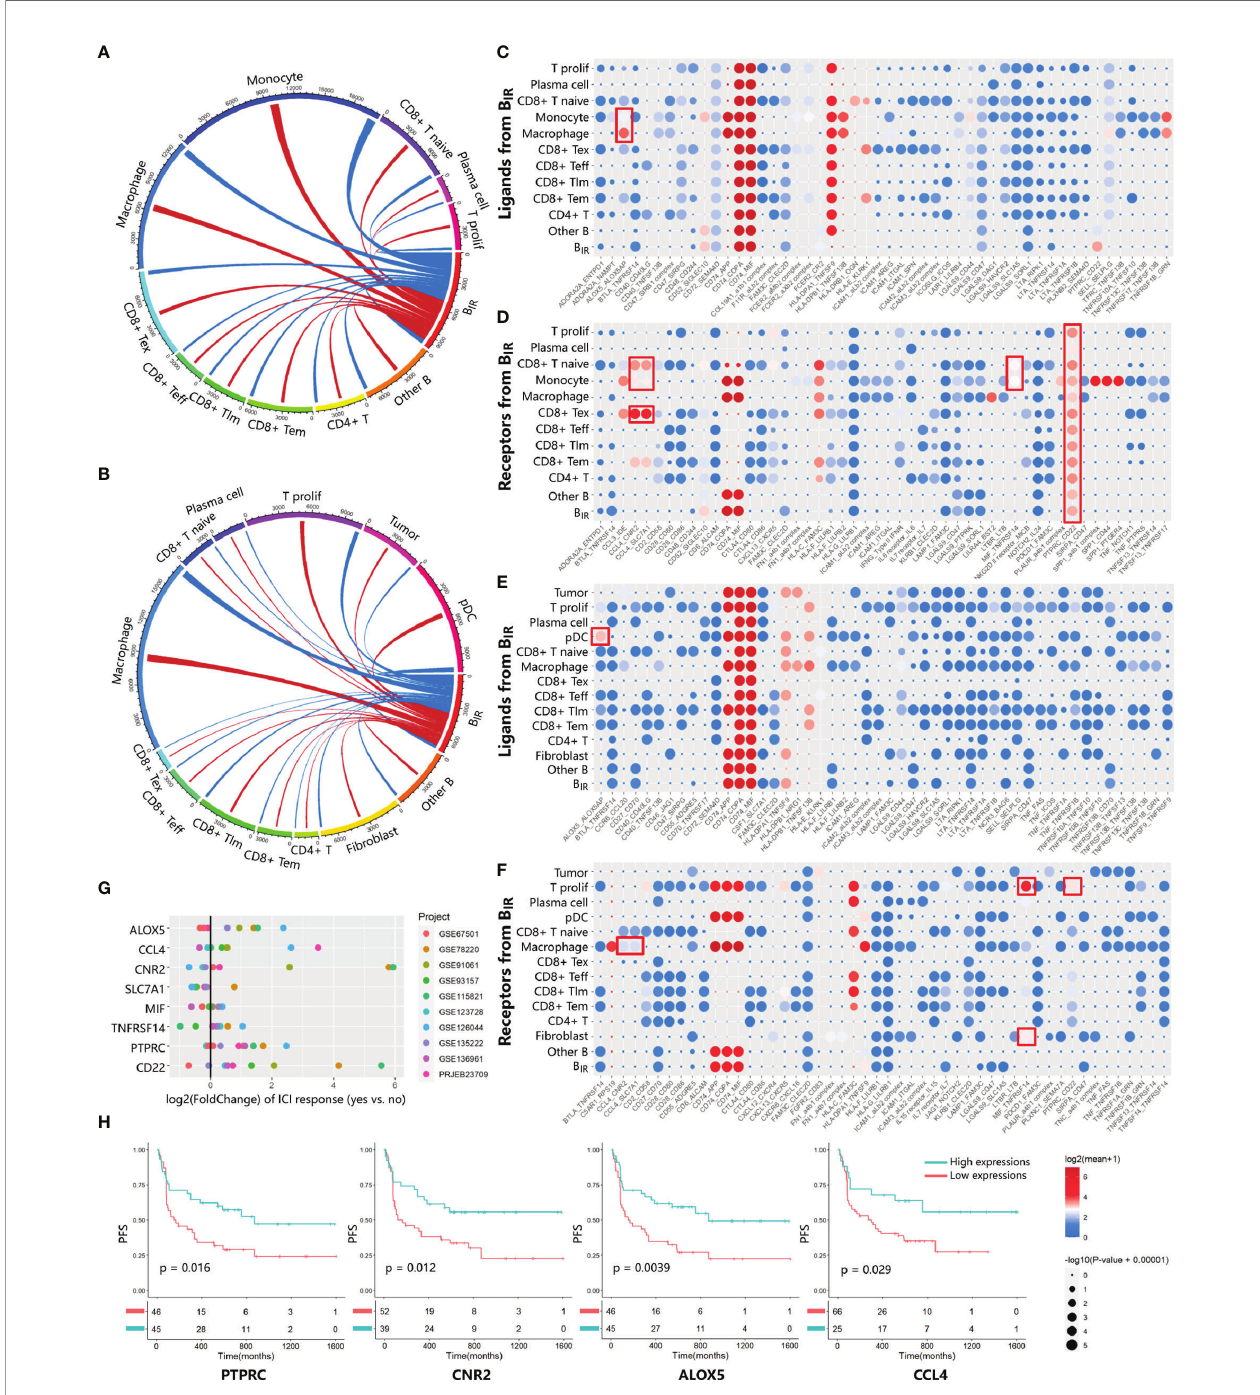
FIGURE 3 | Communication between B IR cells and other cells. (A, B) Chord diagrams of cellular interactome between B IR cells and all other cell clusters from two tumor single-cell atlas GSE120575 (A) and GSE123813 (B) .The number of interactions among clusters are indicated by line thickness.Interactions between ligands in B IR cells and receptors in other clusters are marked in red. Interactions between receptors in B IR cells and ligands in other clusters are marked in blue. (C – F) Overview of signi fi cant ligand- receptor interactions from data sets GSE120575 (C, D) and GSE123813 (E, F) . Ligands (C, E) and receptors (D, F) expressed by B IR cells interact with relevant molecules of all other clusters. Ligand-receptor pairs with strong interaction are portrayed as circles with low P values (large circles) and high means of the average expression level of two interacting molecules (red circles). Meaningful interactions in both data sets are marked by red rectangles. (G, H) Evaluation of the prognostic signi fi cance of genes from meaningful ligand-receptor interactions. (G) The fold change of gene expression in ICIresponders as compared to non-responders is calculated for eight genes from meaningful ligand-receptor interactions.10 datasets from patients treated with ICI therapy are indicated by colors. Only signi fi cant fold change (p<0.05) are showed in the plot. (H) Correlations offour genes in PRJEB23709 with progression-free survival(PFS). The red line designates the samples with lowly expressed genes,and the blue line indicates the samples with highly expressed